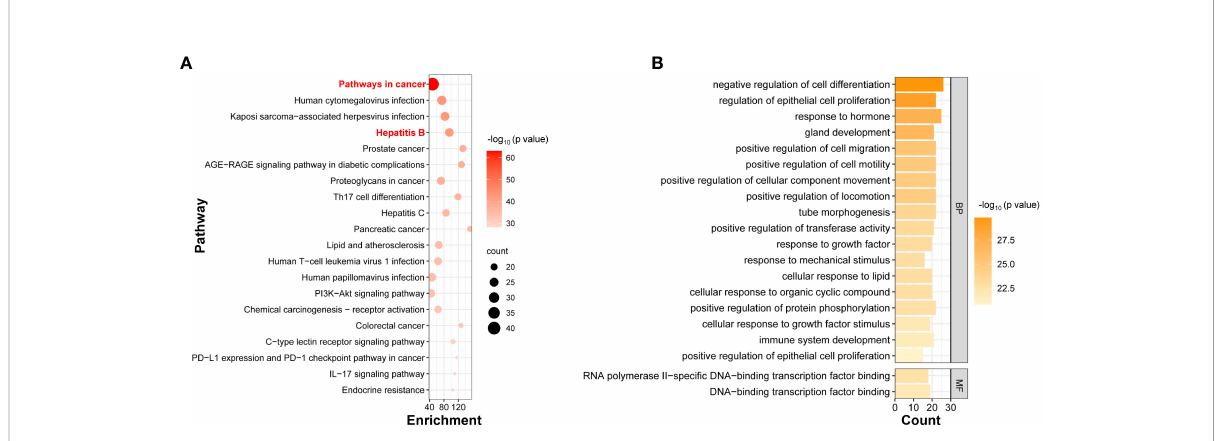
FIGURE 5 The functional enrichment analysis of 47 targets. (A) The top 20 KEGG pathways by p value. The bubble size indicated the number of targets clustered, and the color indicated the p value of the enrichment analysis. (B) The GO terms were sorted according to p value, with the most signi fi cantly enriched terms at the top. BP, biological processes. MF, molecular functions. The length of each bar indicated the number of targets clustered, and the color indicated the p value of the enrichment